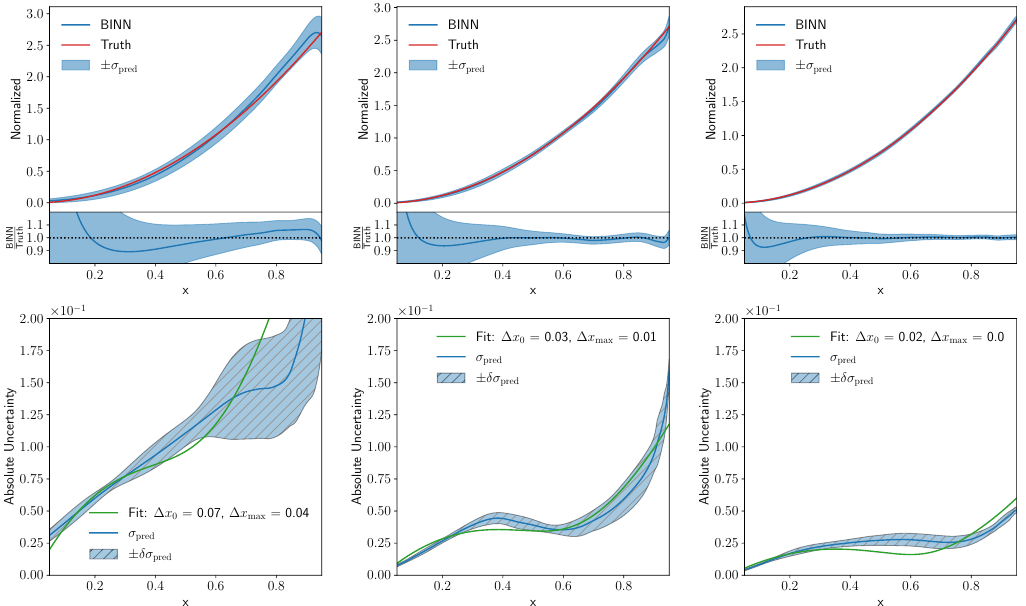
Figure 7: Dependence of the density (upper) and absolute uncertainty (lower) on the training statistics for the kicker ramp. We illustrate BINNs trained on 10k, 100k, and 1M events (left to right), to be compared to 300k events used for Fig. 4. Our training routine ensures that all models receive the same number of weights updates, regardless of the training set